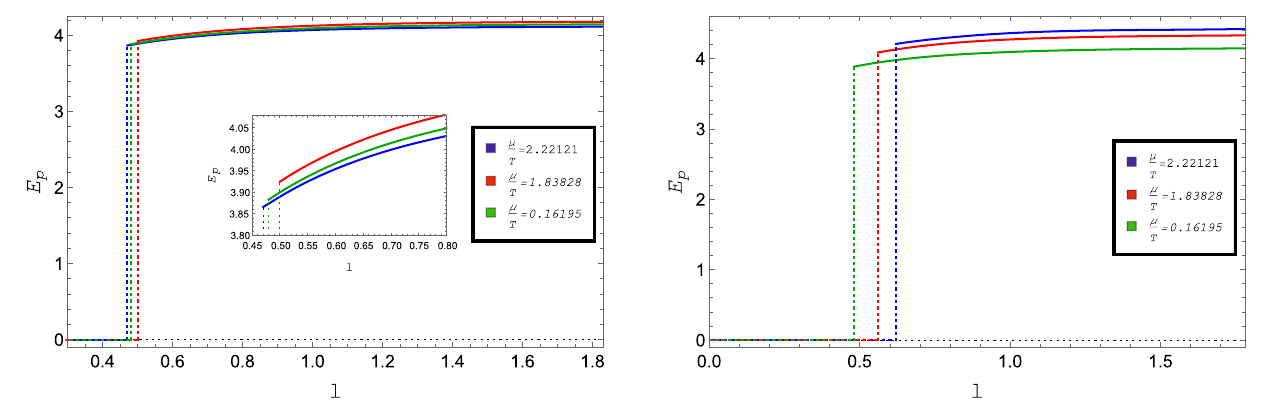
known phase transition between zero and non-zero mutual information, T or equivalently the EoP, is shown by the dashed line. The three different and l (cid:3) with non-zero chemical are chosen to have the same T equal to 0 . 37 and different values of μ T T μ